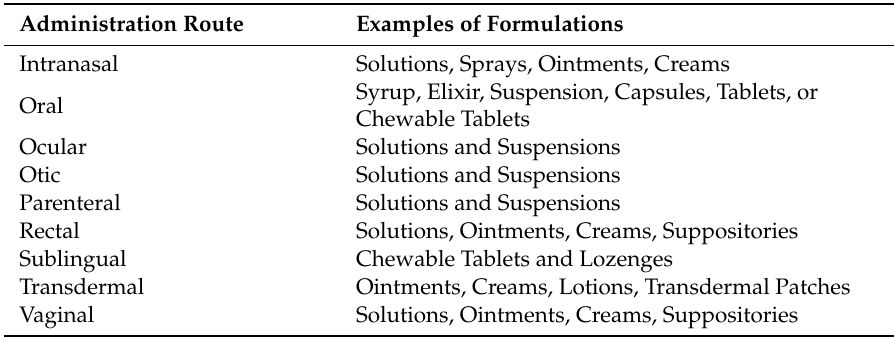
Table 1. Most common routes of drug